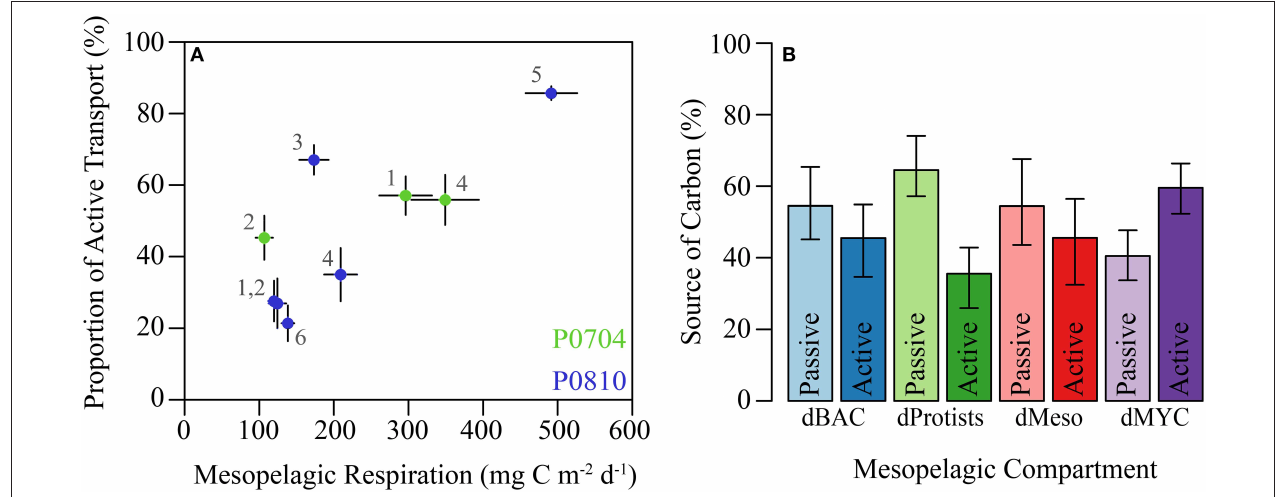
FIGURE 8 | (A) Proportion of active transport relative to total export verses total mesopelagic respiration by residents (i.e., dBAC, dHNF, dMIC, dSMZ, dLMZ, dMYC, dGEL). Cruises are colored and cycles are as shown. (B) Relative proportions of carbon demand supplied by passive or active flux for the indicated mesopelagic groups. Source was calculated using indirect flux analysis (Section Indirect analysis) to determine the indirect contribution epipelagic detritus (passive) and vertically migrating mesozooplankton (active). Error bars are ± 1 SD.